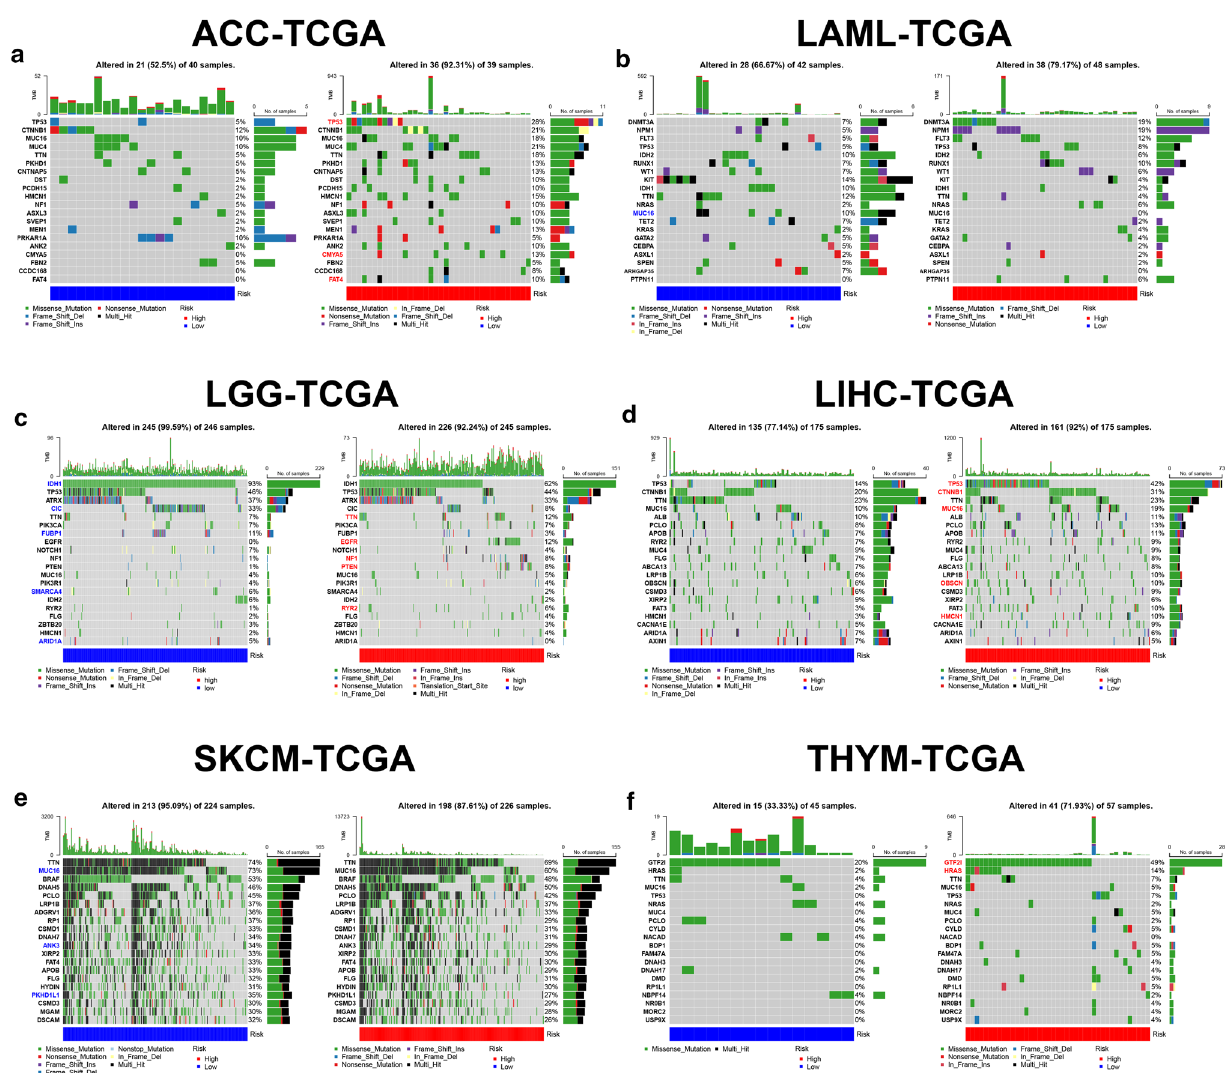
Fig. 11 Gene mutation status in low- and high-risk groups. The oncoplots showed the mutation status of the top 20 most frequently mutated genes of ACC ( a ), LAML ( b ), LGG ( c ), LIHC ( d ), SKCM ( e ) and THYM ( f) at low- and high-risk groups, with different colors referring to gene mutation types. The mutation rate of each gene between the two risk-groups was compared by Fisher’s exact test, and the genes with higher mutation rate in low- or high-risk groups were highlighted by blue or red color